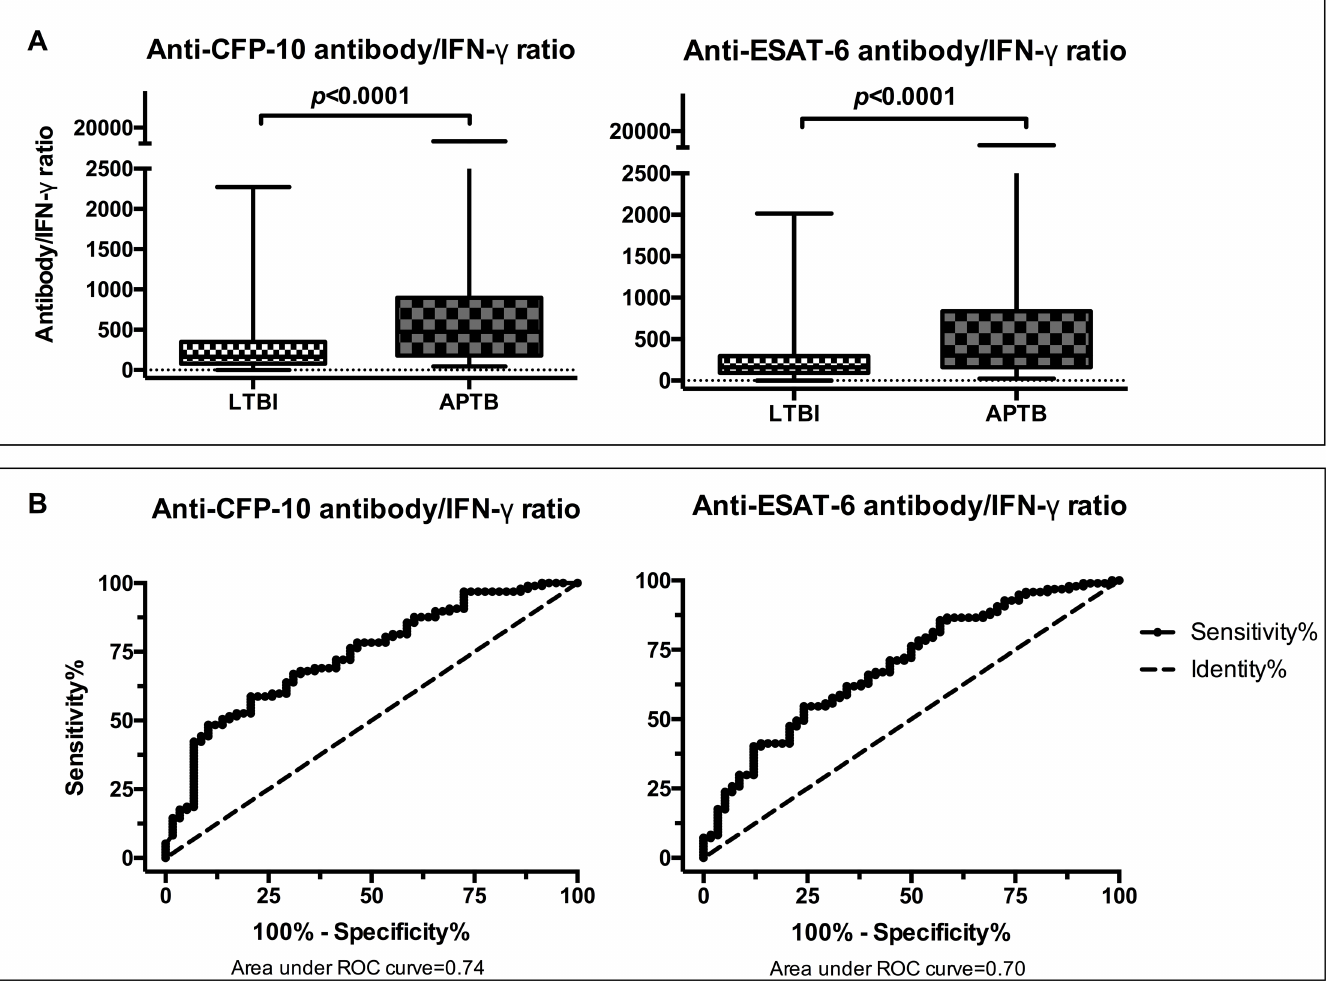
Fig 4. Anti-CFP-10 and anti-ESAT-6 antibody/IFN- γ ratios in APTB cases & individuals with LTBI and their discriminatory potential. Panel A: box and whisker plots showingdifferences in antibody/IFN- γ ratio betweenthe two groups. The Wilcoxon rank-sum test was used for comparisons. Panel B: Receiveroperatorcharacteristic curves showingdiscriminatory potentialat different antibody/IFN- γ ratio cut-offs.